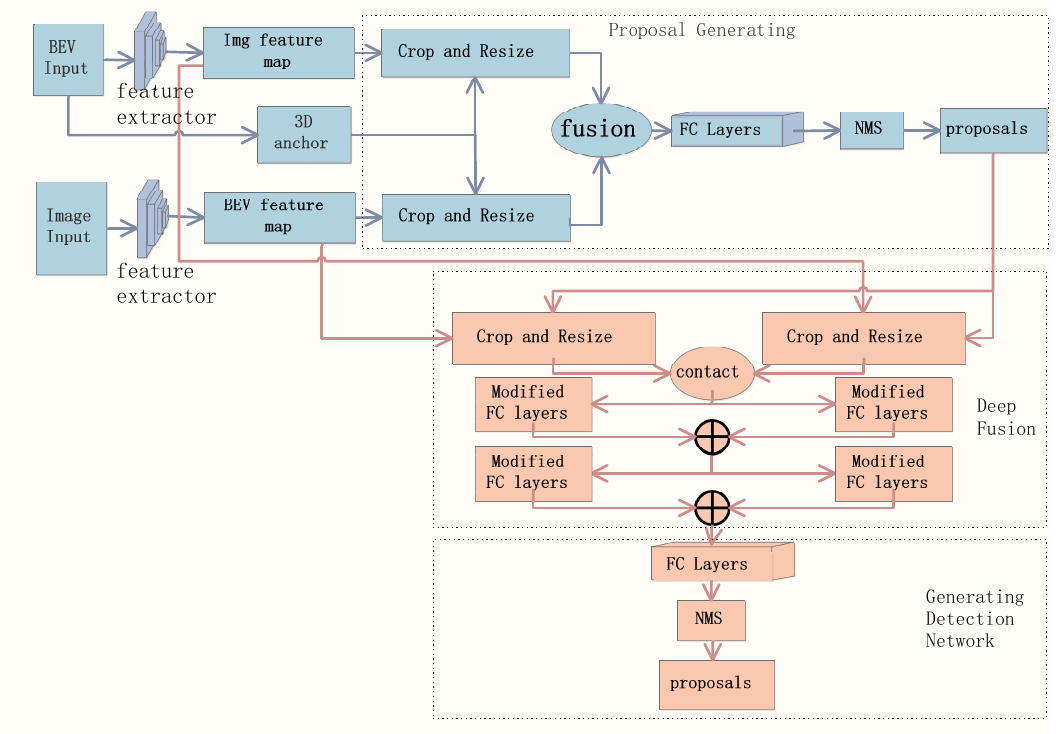
Figure 1. The object detection architecture, where the blue part is proposal generation network and the red part is the deep fusion detection